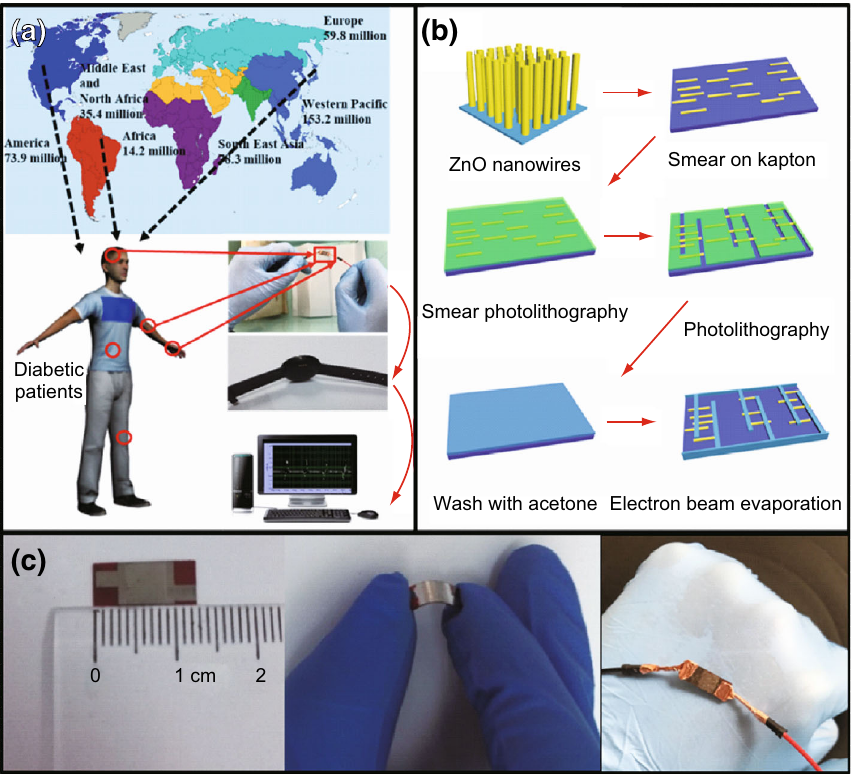
Fig. 1 Potential application, device architecture, material system, and experimental design of self-powered implantable skin-like glucometer. a Potential application. b Device architecture, material system, and fabrication procedure. c Optical images of the